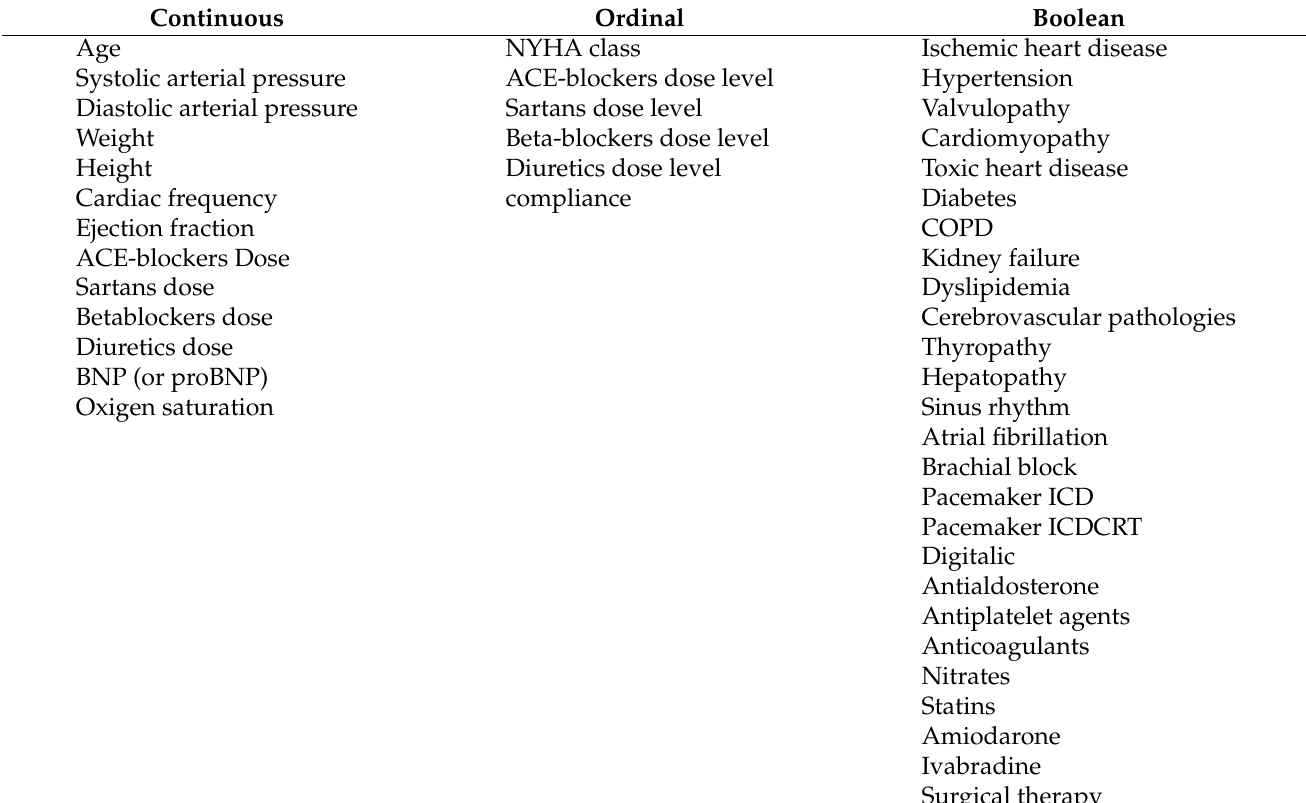
Table 1. Features recorded for each visit by